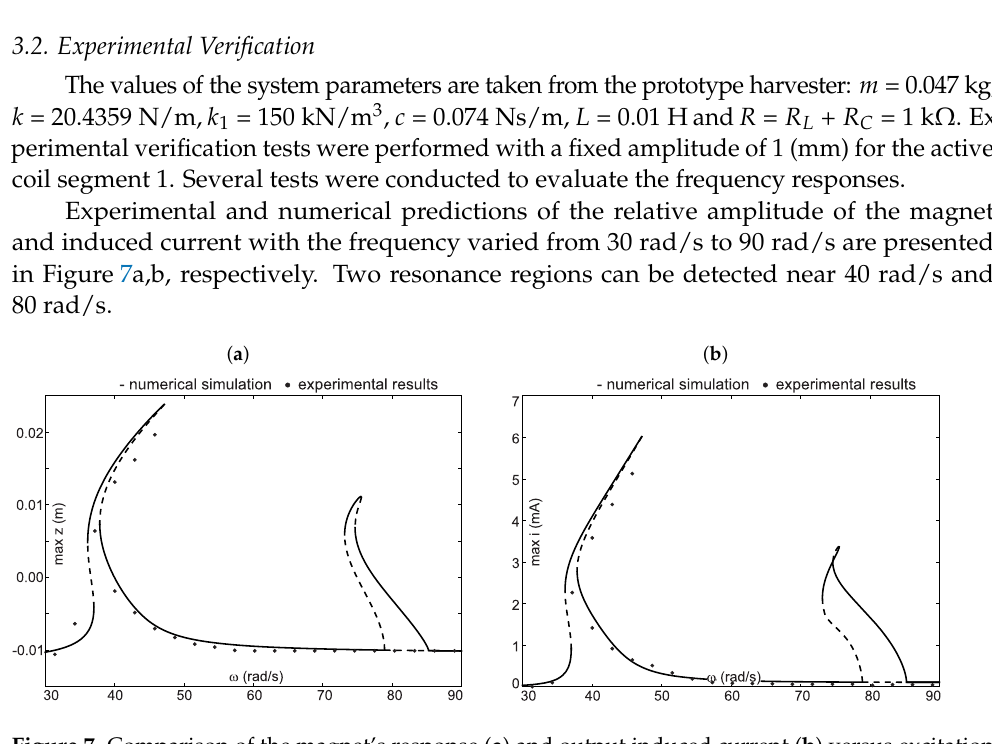
Figure 7. Comparison of the magnet’s response ( a ) and output induced current ( b ) versus excitation frequencies obtained from the simulation model and